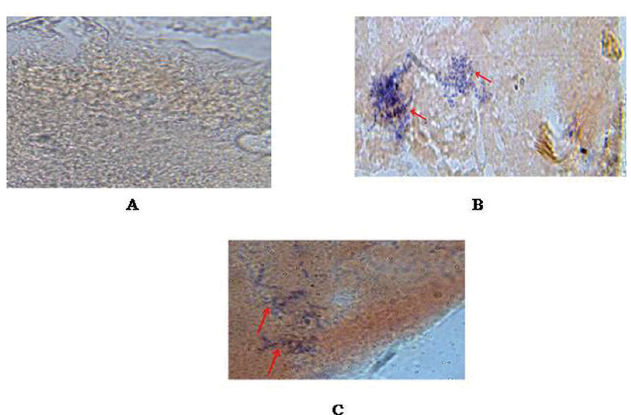
FIGURE 9 - Immunohistochemistry performed on the brain sections using anti-tyrosine hydroxylase (primary antibody) and alkaline phosphatase (secondary antibody). BCIP-NBT solution was used as a substrate (100X) [A-PD fly; B-Control; C-PD fly exposed to 100 µM of